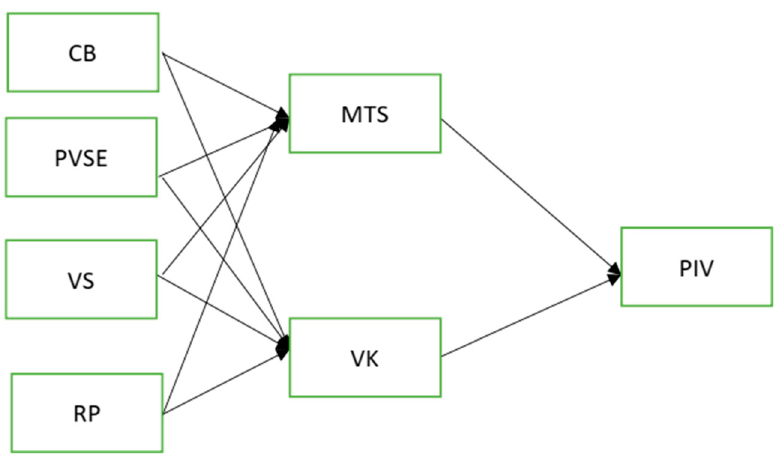
Figure 1. Research framework. Conspiracy belief (CB), Vaccine Knowledge (VK), Vaccine Safety (VS), Risk Perception (RP), Parental Vaccine Intention (PIV), Parental Vaccine Self-Efficacy (PVSE) and Mistrust in Science (MTS).